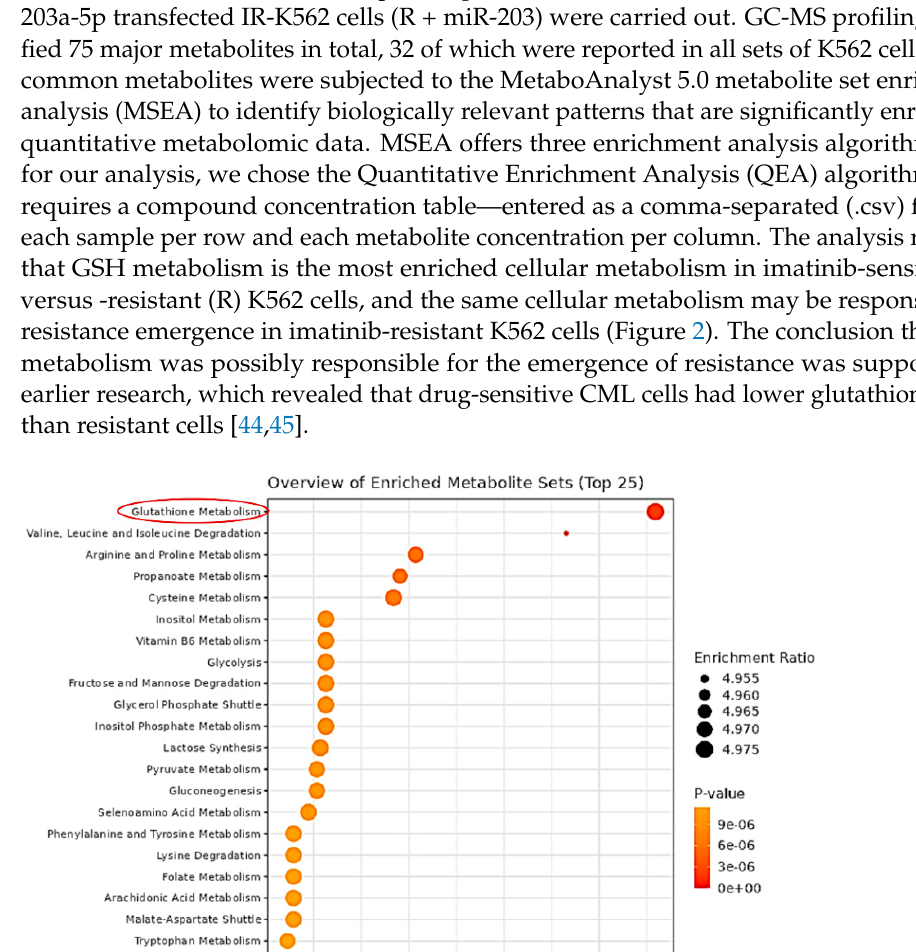
rithm summary plot for all significantly transformed metabolites between the imatinib-sensitive (C)